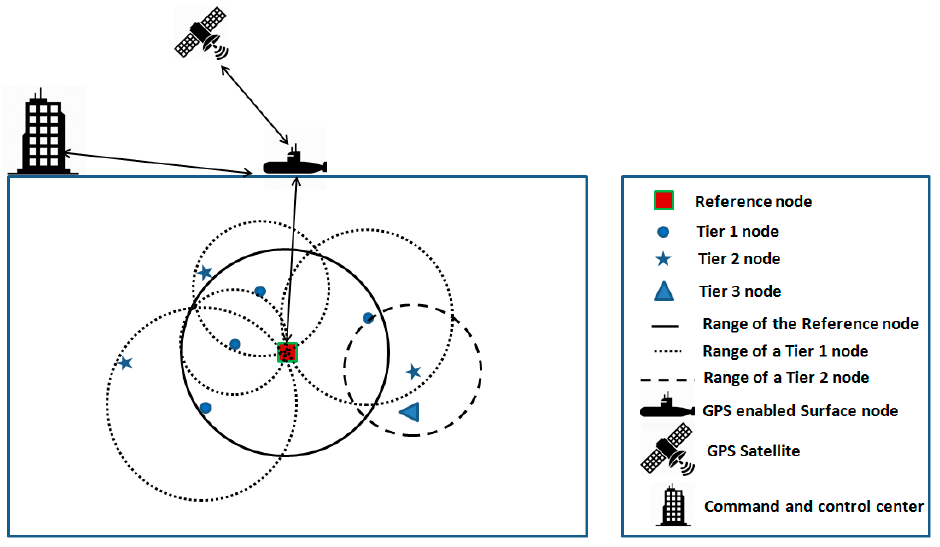
Figure 1. Network architecture of our proposed localization scheme.